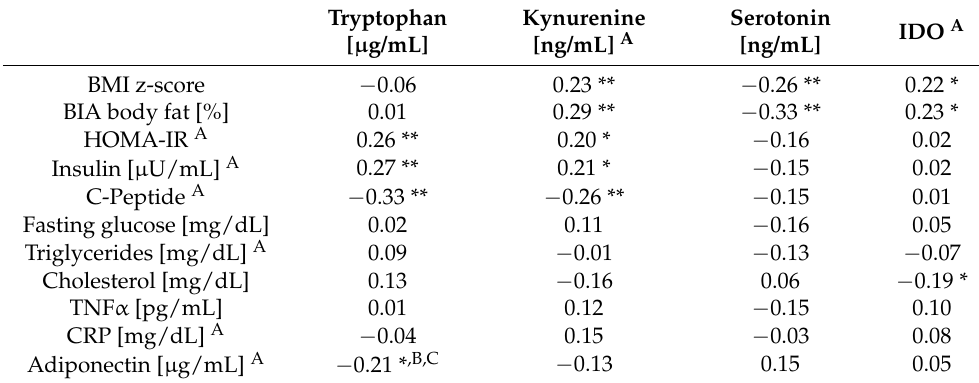
Table 2. Correlations of tryptophan, kynurenine, and serotonin with metabolic parameters.